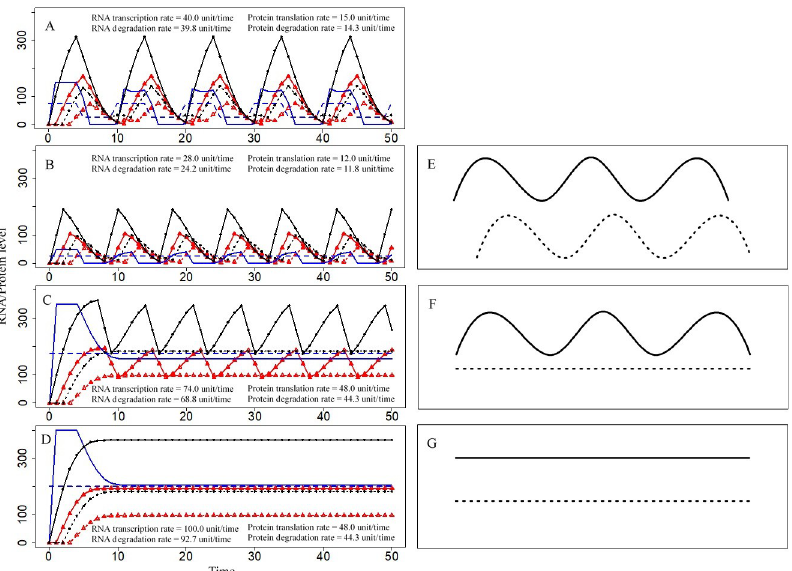
Fig 5. Relationship between RNA and protein level fluctuations. Blue curve represents the demand for RNA activity (DRA). Blue dashed line represents the demand for protein activity (DPA). Red curve represents total RNA activity (TRA), and triangles on the curve are predicted values. Red dashed line represents total protein activity (TPA), and triangles on the line are predicted values. Black curve with dots represents the total amount of RNA (TR), and points on the line are predicted values of RNA. Black dashed line represents the total amount of protein (TPro), and the points on the line are the predicted values of protein. The values of the parameters are given in S3 Table. The x-axis is time, and the unit of time is RNA/Protein age, which is standardized as unitless values. The y-axis is the RNA/protein level, which is standardized as unitless values. (A) Cycling TR and cycling TPro under the condition of cycling DPA (DPA rotated between 25 and 75). (B) Cycling TR and cycling TPro under the condition of stable DPA = 25. (C) Cycling TR and stable TPro under the condition of stable DPA = 175. (D) Stable TR and stable TPro under the condition of stable DPA = 200. (E) Cycling TR and cycling TPro in the literature [39]. (F) Cycling TR and stable TPro in the literature [39]. (G) Stable TR and stable TPro in the literature [39].